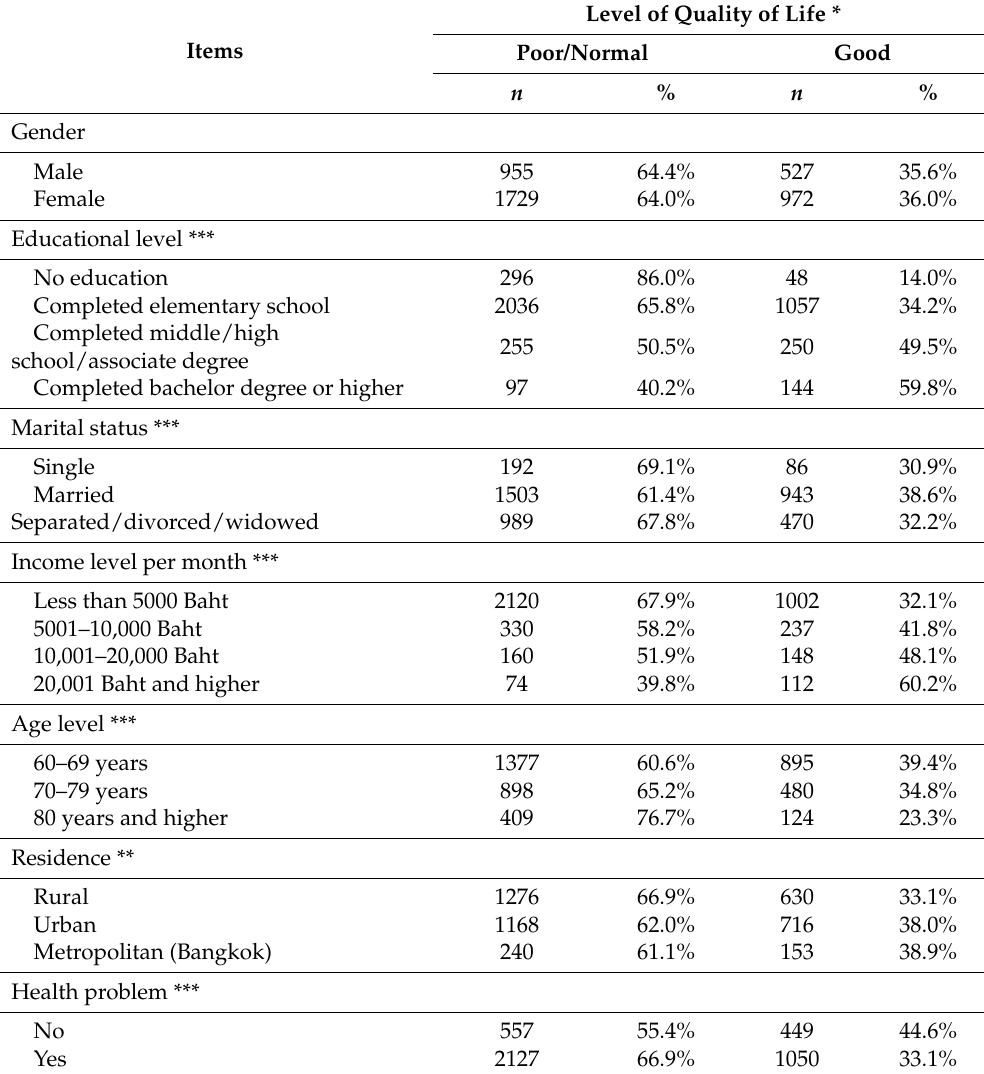
Table 3. Factors associated with quality of life among Thai older adults using χ 2